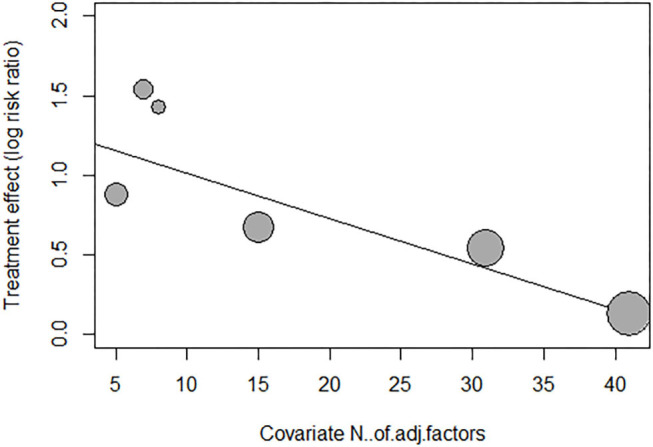
Meta-regression.